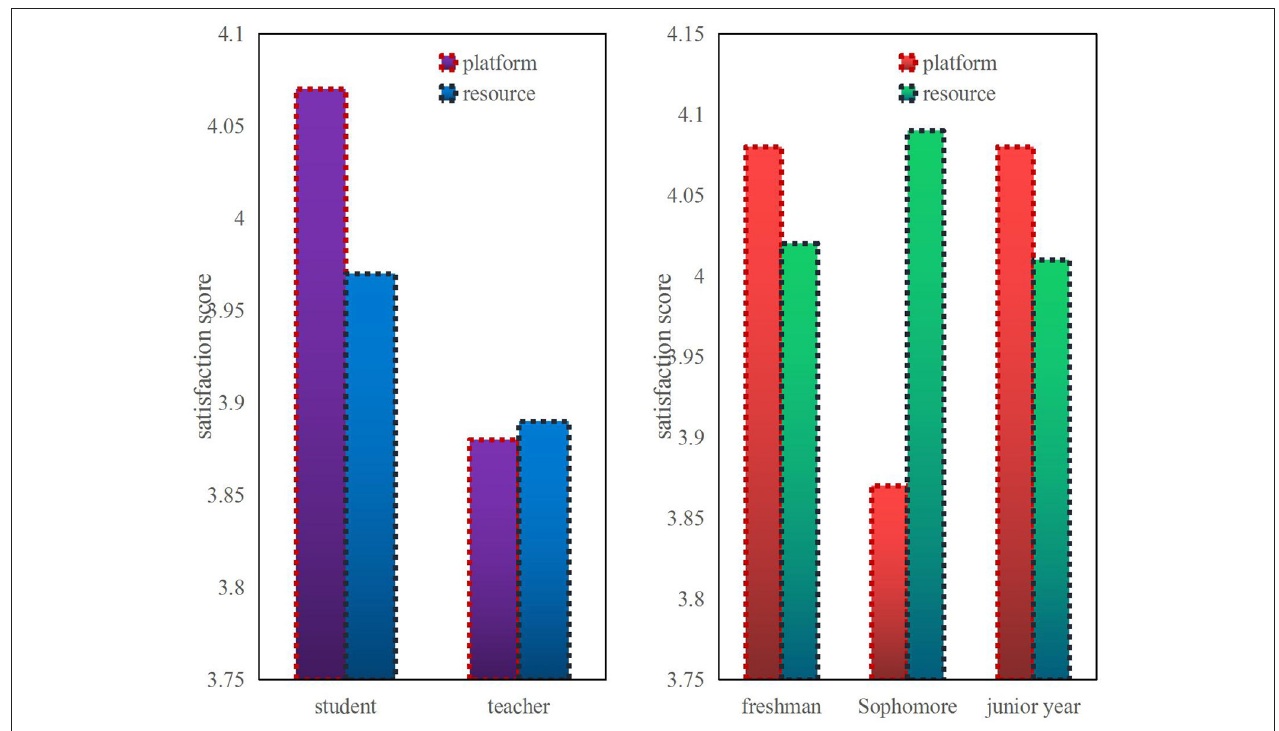
FIGURE 3 | Comparison of satisfaction of different objects with platforms and resources.